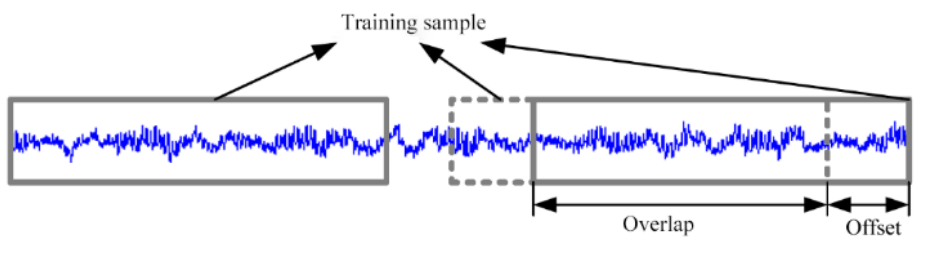
Figure 4. Trend of three − phase current.